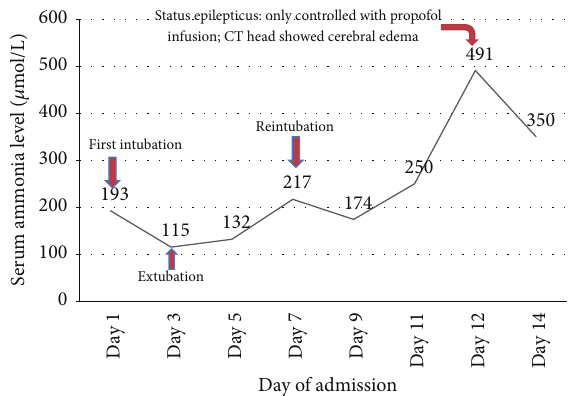
Figure 2: Graphical representation of serum ammonia level and associated events. Fluctuation of serum ammonia level during ICU course on this patient. Level of ammonia and mental status did not improve much with conventional treatment of hyperammonemia. The patient showed status epilepticus, which did not improve with midazolam and phenytoin and needed propofol drip to control the